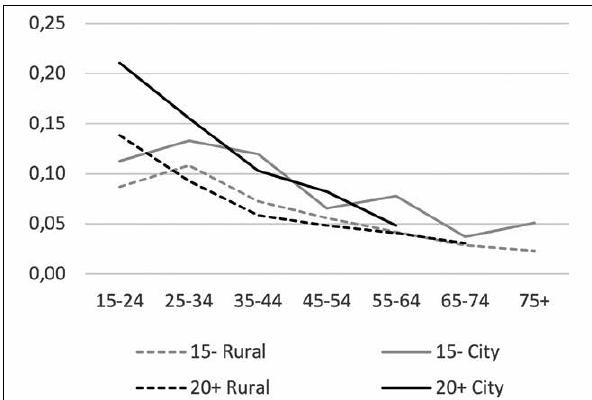
Figure 3b: Fixed-effects linear probability model of housing being a personal issue, 3-way interaction age, education (up to 15 v. 20+ years) and urbanisation (rural vs